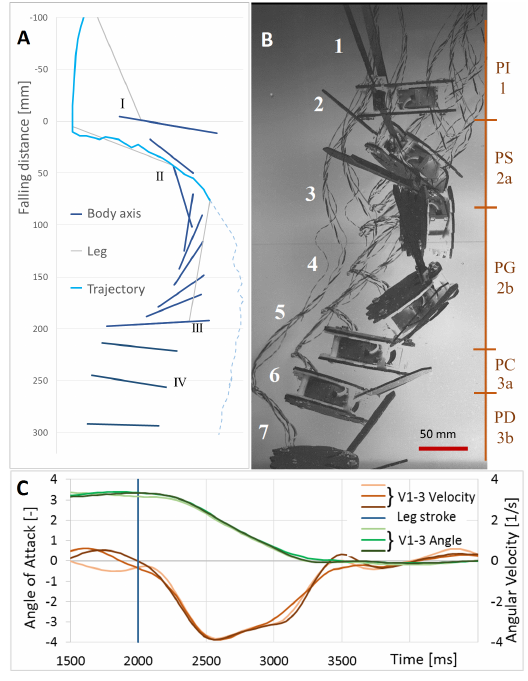
Figure 4. Turning movement of O-Typus. B. observed turning behavior with five characteristic Phases (Initializing PIˆ=1, Striking PSˆ=2a, Gliding PGˆ=2b, Counterstriking PCˆ=3a, Descending PDˆ=3b); ł∆t = 0,36 s. A. Course of the body axis and trajec- tory of the left leg’s tip. Leg positions at the end of PI (I), end of PS (II) and the target position (III) in grey. IV shows the maximal overwinding; ∆t = 0,2 s (0,1 s during passive turning (II-III)). C. Angle of attack (green) and angular velocity (red) of three runs.